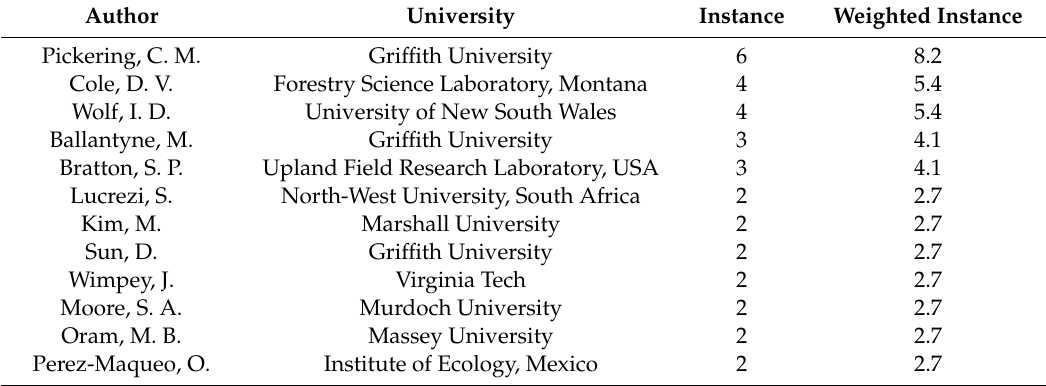
Table 2. Repeat first authors of recreational ecology papers by university (JOST, TM, JEM, EM, 1976– 2017).